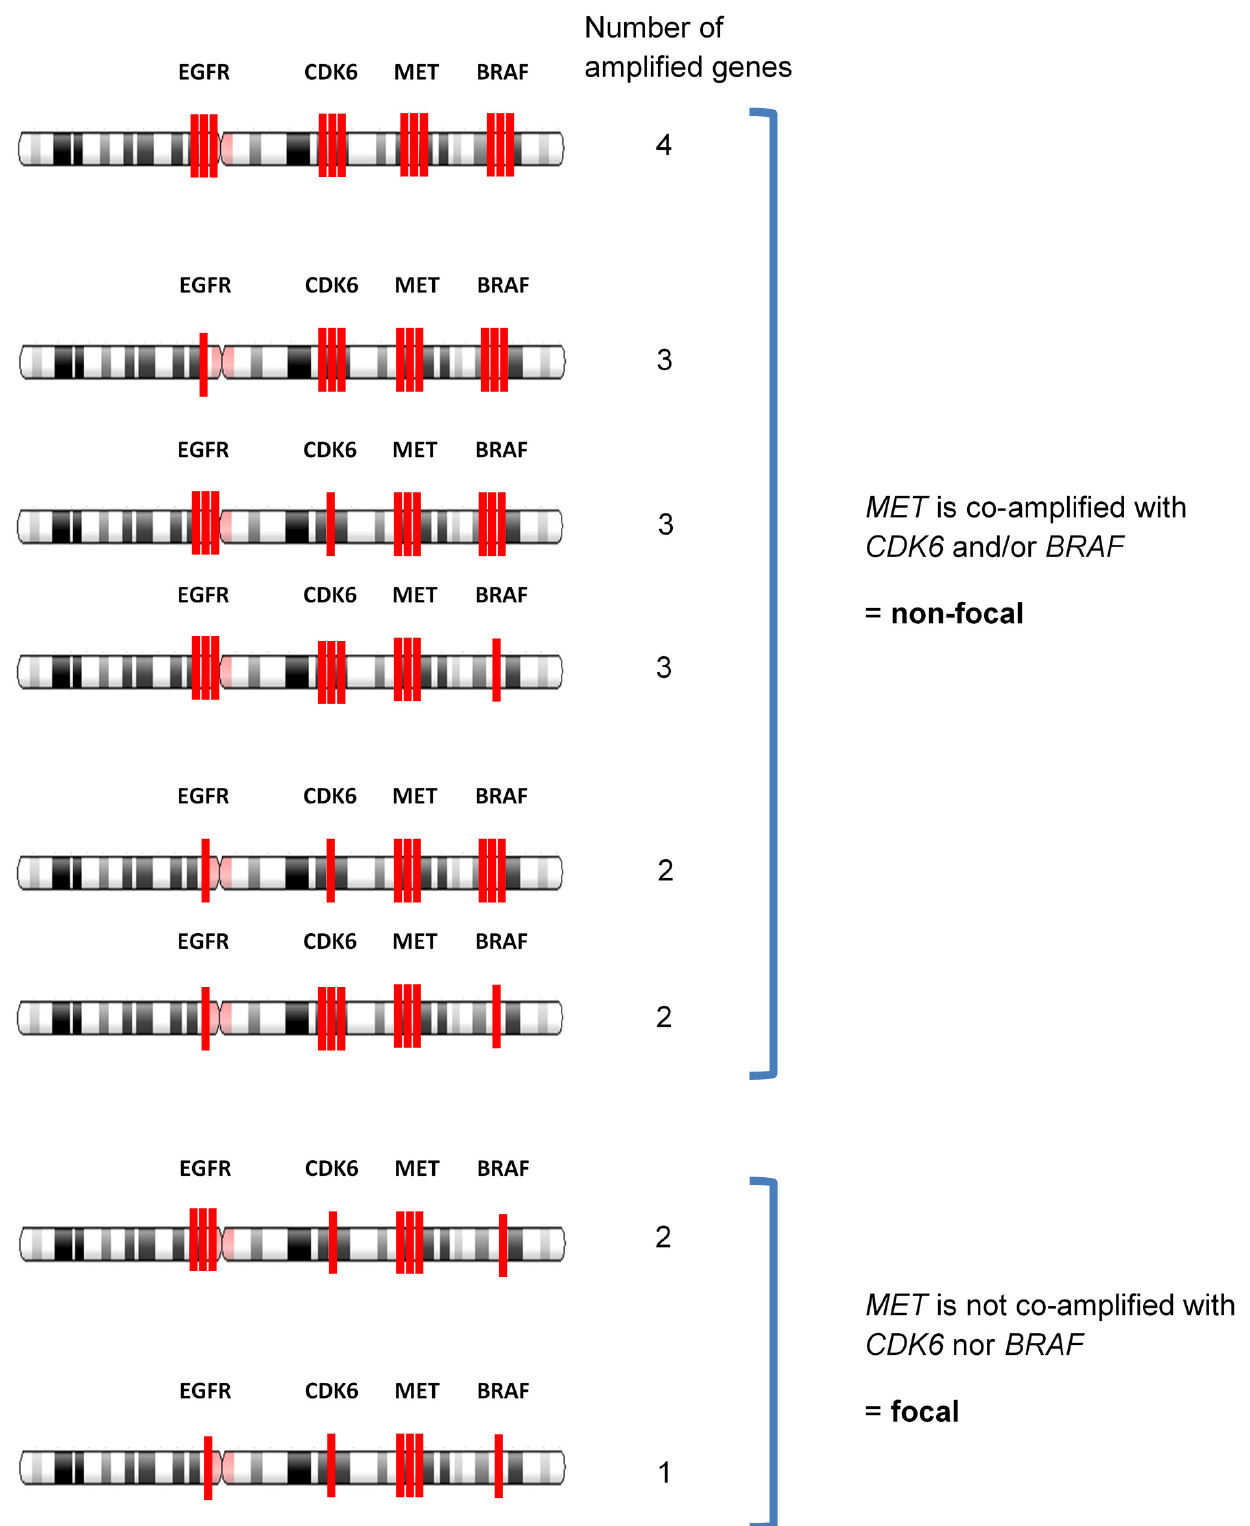
Figure 2. Patterns of amplified genes on chromosome 7 and definition of focal/non-focal. There are four genes on chromosome 7 for which amplification can be detected by Guardant360, and we defined MET focal/non-focal by the pattern of amplification of the four genes; MET is co-amplified with CDK6 and/or BRAF = non-focal and MET is not co-amplified with CDK6 nor BRAF = focal. EGFR amplification was excluded from the definition of focal/non-focal because it tended to show independent behavior.